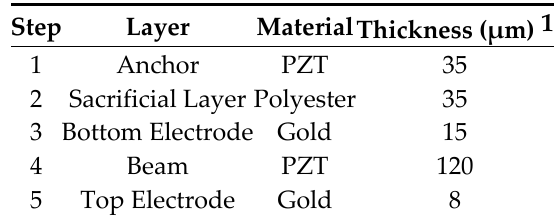
Table A1. Screen-printing steps and materials used for the layers. For gold and sacrificial layer, ESL8836 and ESL244t commercial inks were used respectively. The PZT ink is homemade. Step Layer